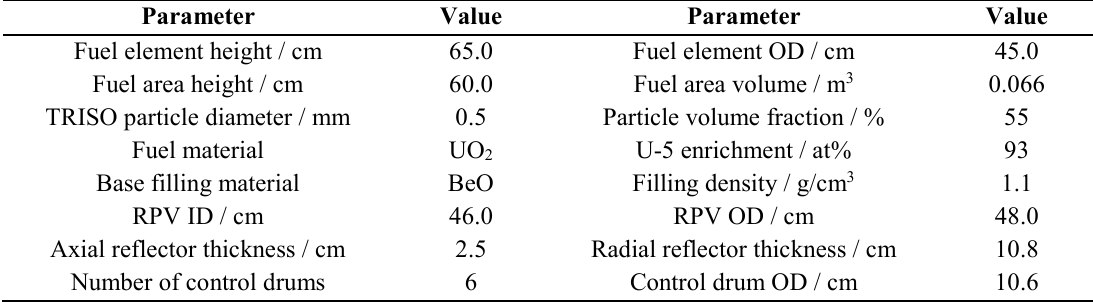
Table I. Key design parameters of IGCR-200 reactor